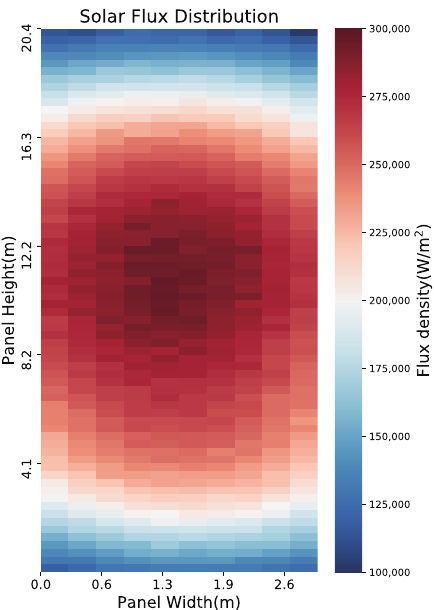
Figure 6. An example of the solar flux distribution on the panel.